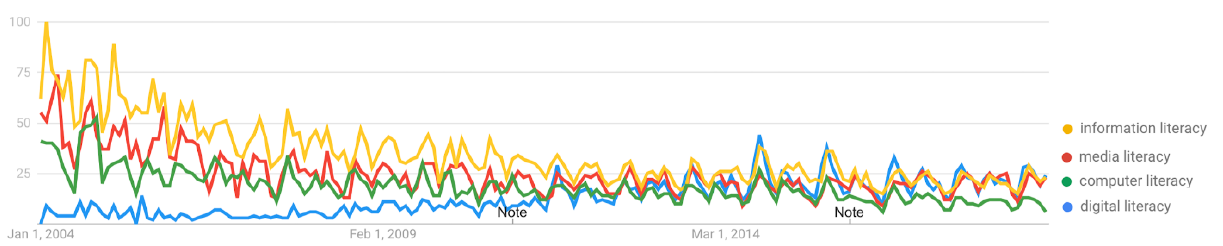
Figure 2. GoogleTrends depiction of usage patterns for computer, information, media, and digital literacy from 2004 to